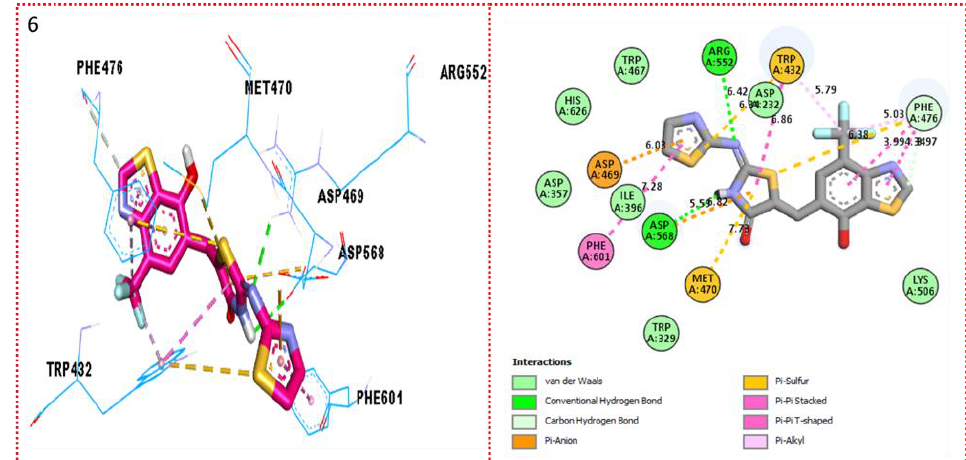
Figure 11. Protein – ligand interaction profile for active analogue against α‐ amylase represents the surface of the corresponding enzyme and indicates the PLI profile for compound 6 .